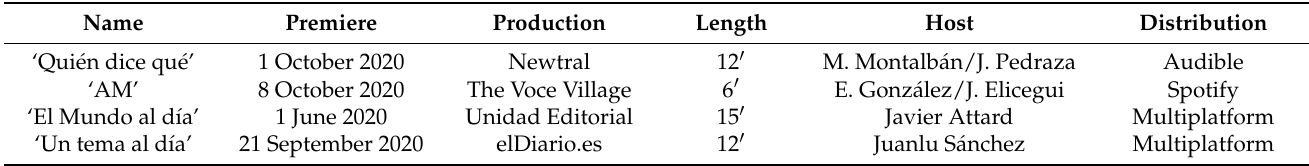
Table 2. Formal variables defined to analyse news